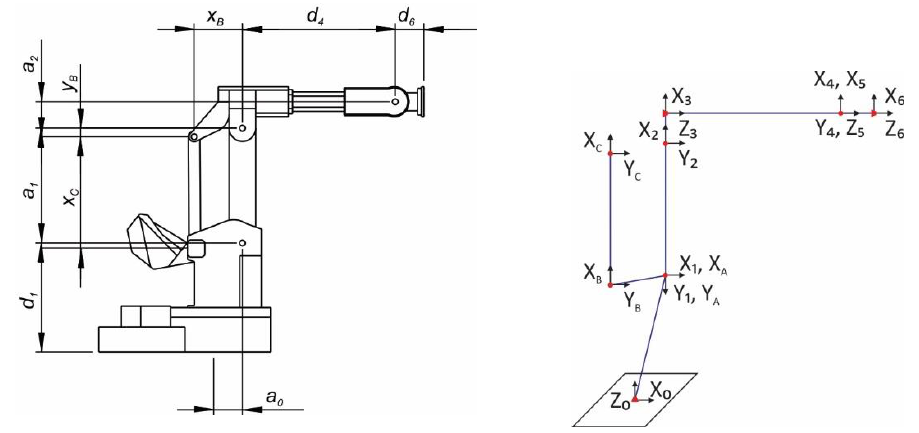
Figure 2. Detailed kinematic model of ACMA XR701.